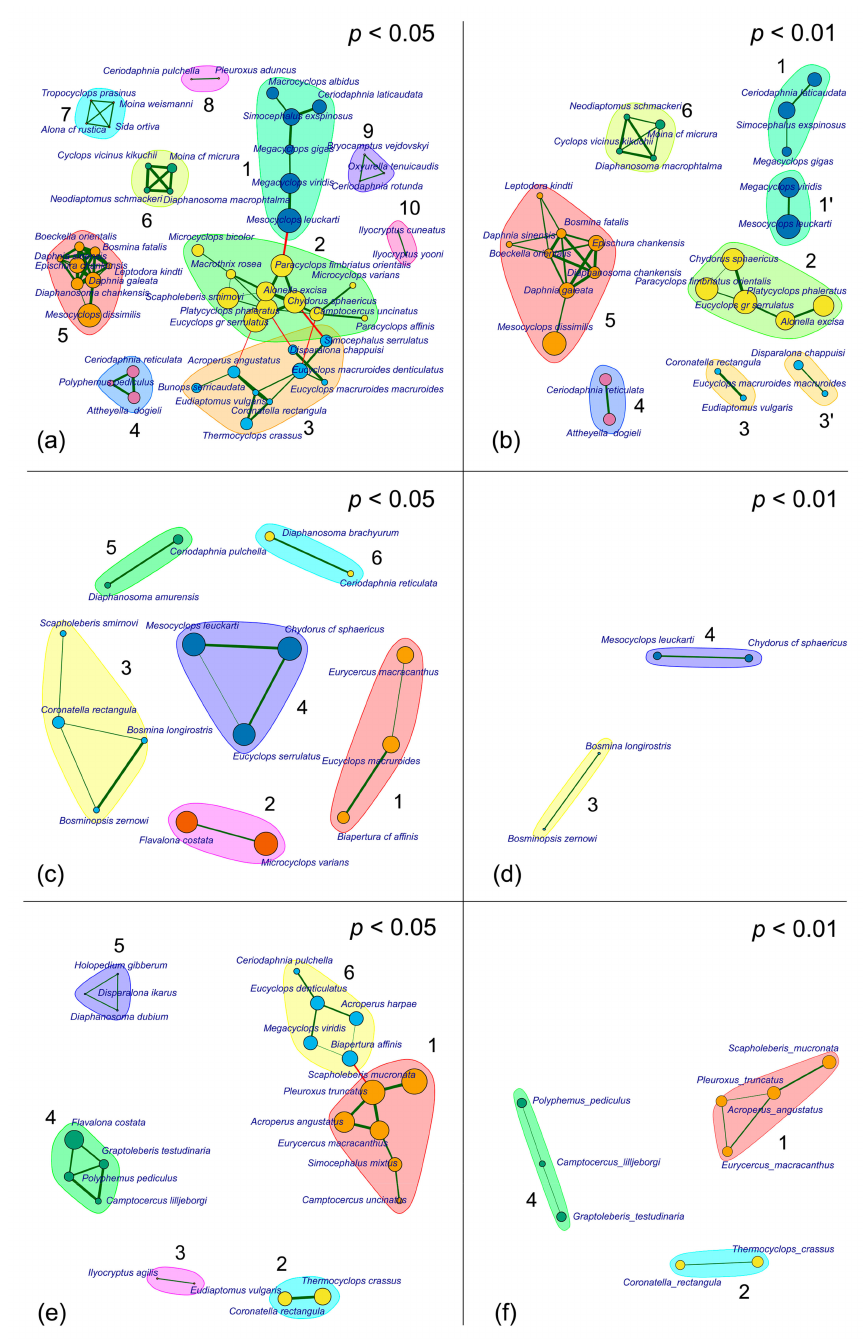
Figure 3. Associations of microcrustaceans in three lakes in the Far East of Russia: ( a ) Khanka Lake at p < 0.05; ( b ) Khanka Lake at p < 0.01; ( c ) Bolon Lake at p < 0.05; ( d ) Bolon Lake at p < 0.01; ( e ) Chukchagir Lake at p < 0.05; and (f) Chukchagir Lake at p <